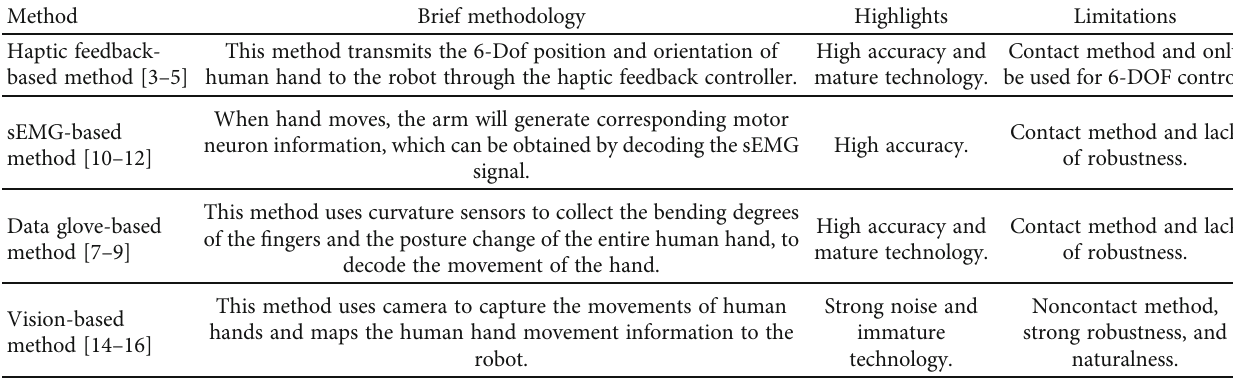
Table 1: Comparison and summary of the hand-based robot teleoperation methods.